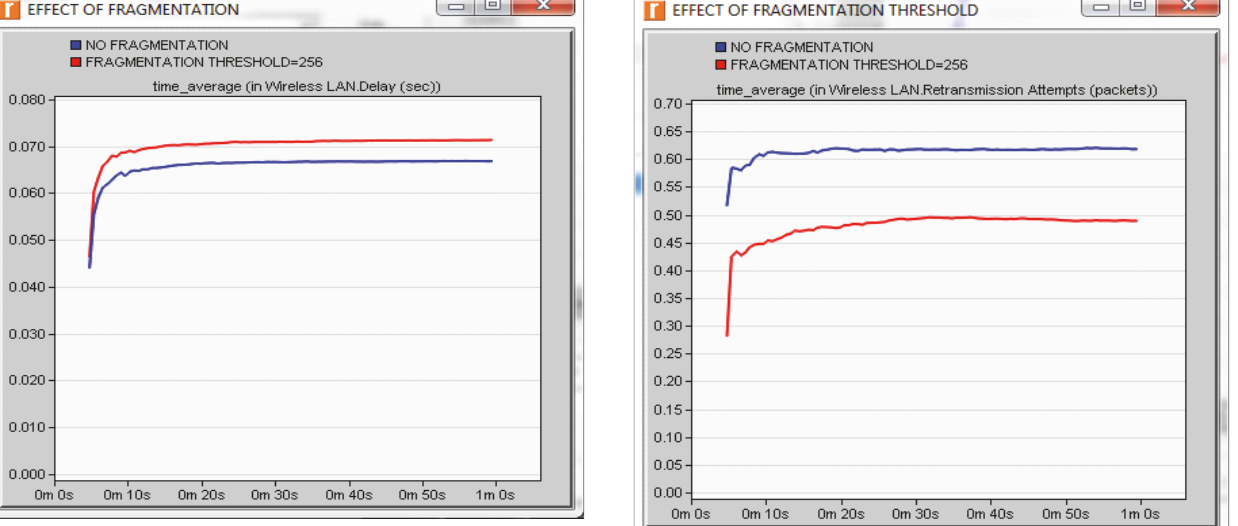
Figure 12: WLAN retransmission attempts with and without frag- mentation.